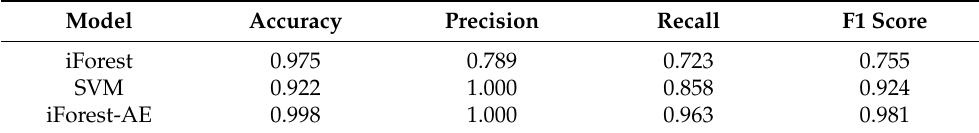
Table 4. Experimental results of the three methods.